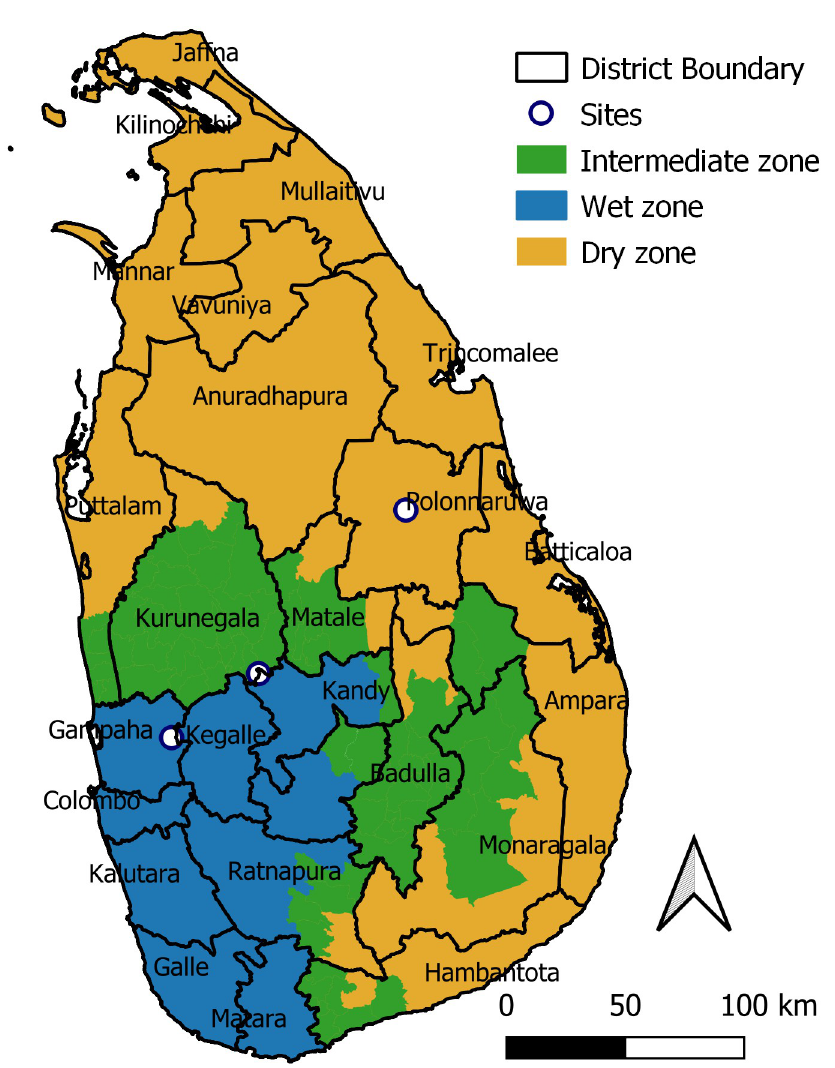
Fig 1. Climate zones according to rainfall, districts and location of sampling sites (Polonnaruwa, Kurunegala and Gampaha) in Sri Lanka where field work was conducted in smallholder food storage facilities. Source base layer & credit base layer: https://data.humdata.org/ published under creative commons attribution for intergovernmental organisations: